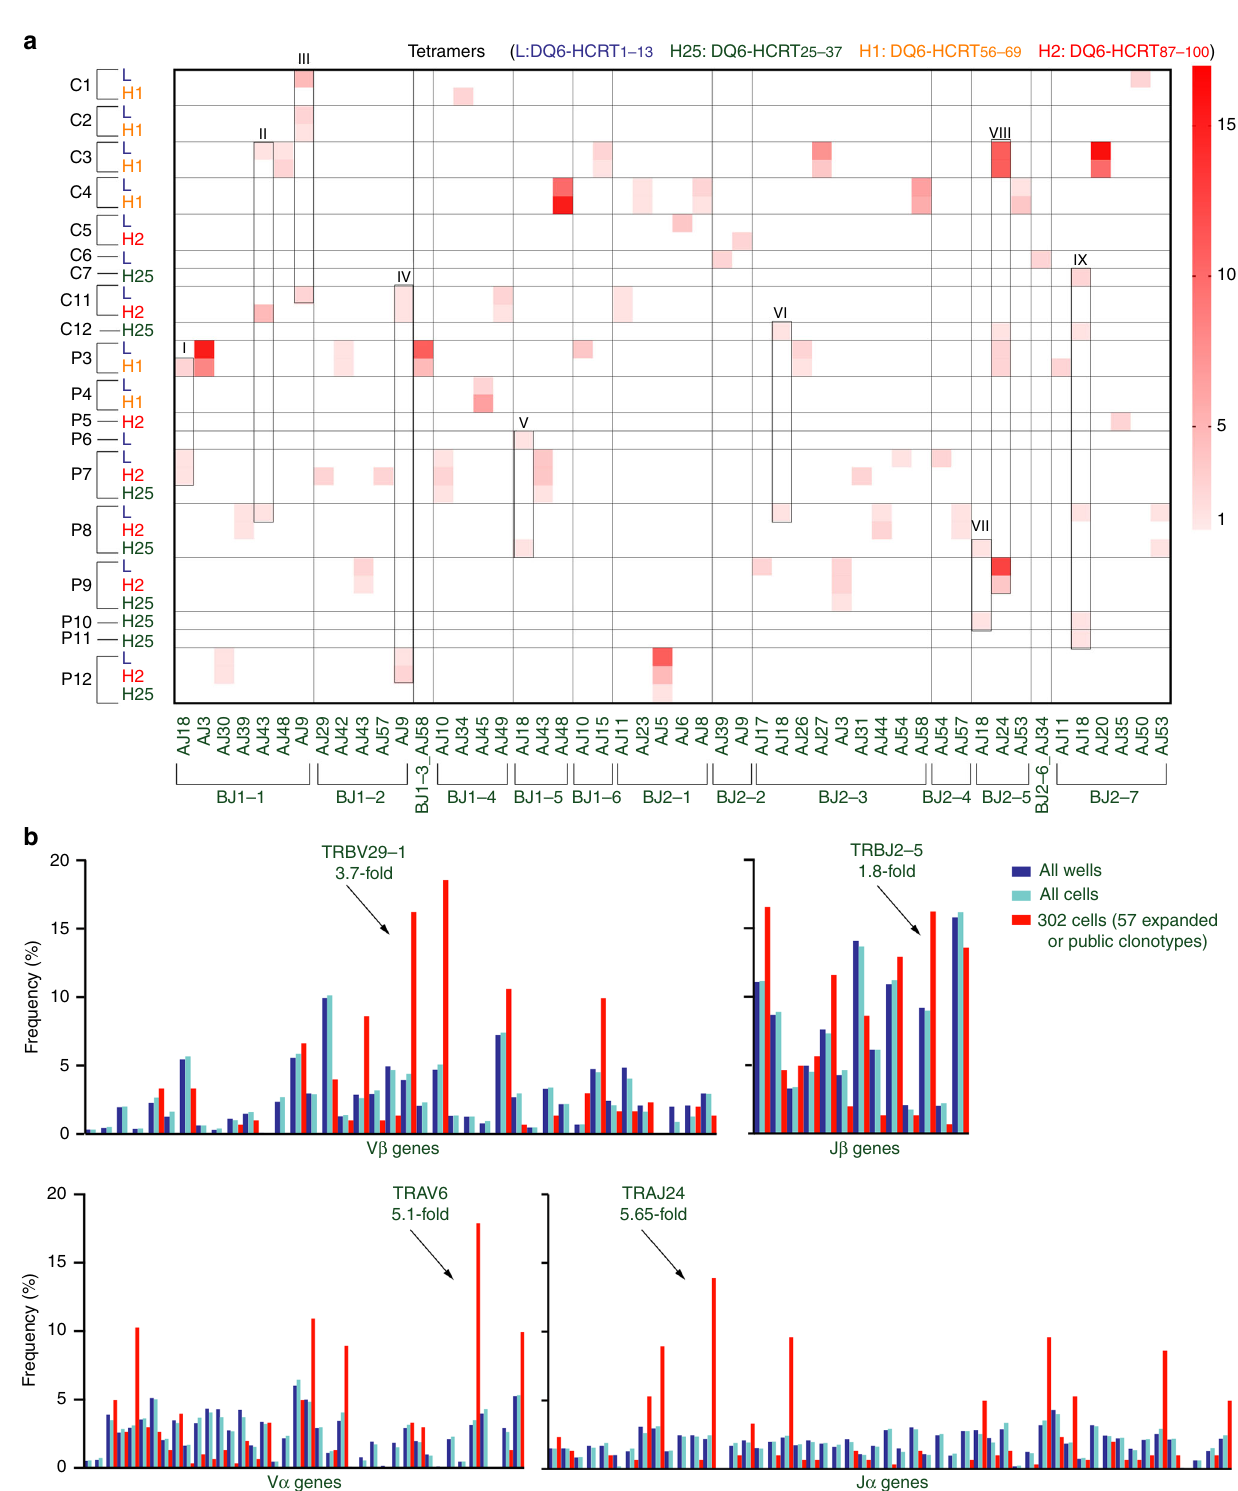
Fig. 4 Public features of clonotypes with more than one isolate from our dataset. a A heat map illustrating 9 groups (I – IX) of cells from multiple subjects sharing identical paired TRBJ/TRAJ genes. Number of isolates of the same clonotype is proportional to the color intensity. Tetramer speci fi city is differentiated by colors. Tetramer categories without any hit on the heat map are not shown. b Frequencies of V or J genes used in 57 TCR α / β clonotypes with multiple isolates compared with “ All Wells ” that return sequences (see Supplementary Data 2) or “ All Cells ” with productive α / β CDR3 sequences (see Supplementary Data 3). Arrows indicate genes used in TRBV29 – 1_TRBJ2-5/TRAV6_TRAJ24-expressing cells, with fold increase compared to “ All Cells